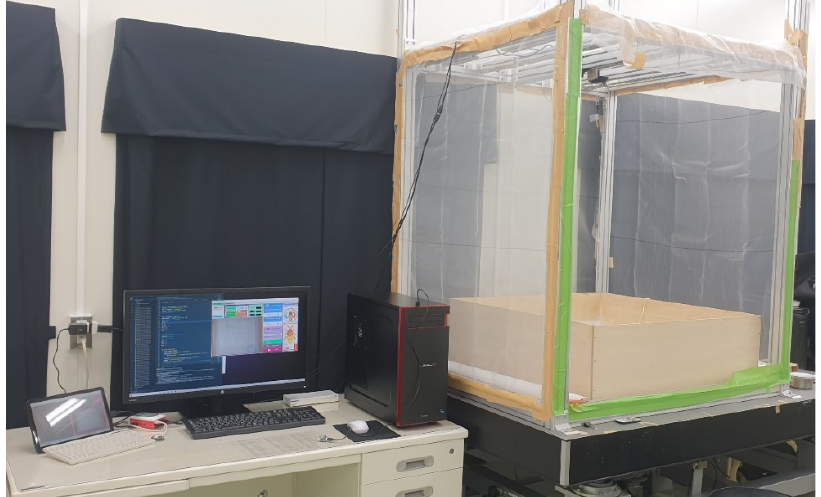
Figure 8. Photo of a teleoperated experimental testbed.